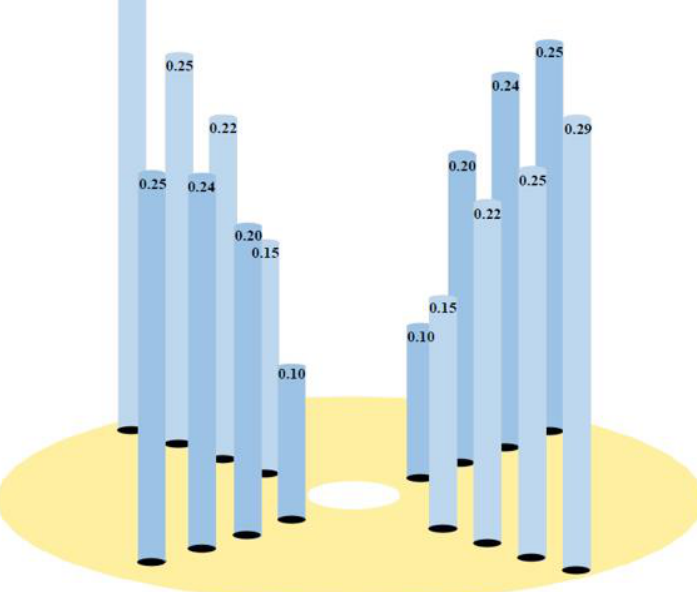
Figure 6. Diagram of cross-sectional strength of simulated test pile 1 (unit: MPa).